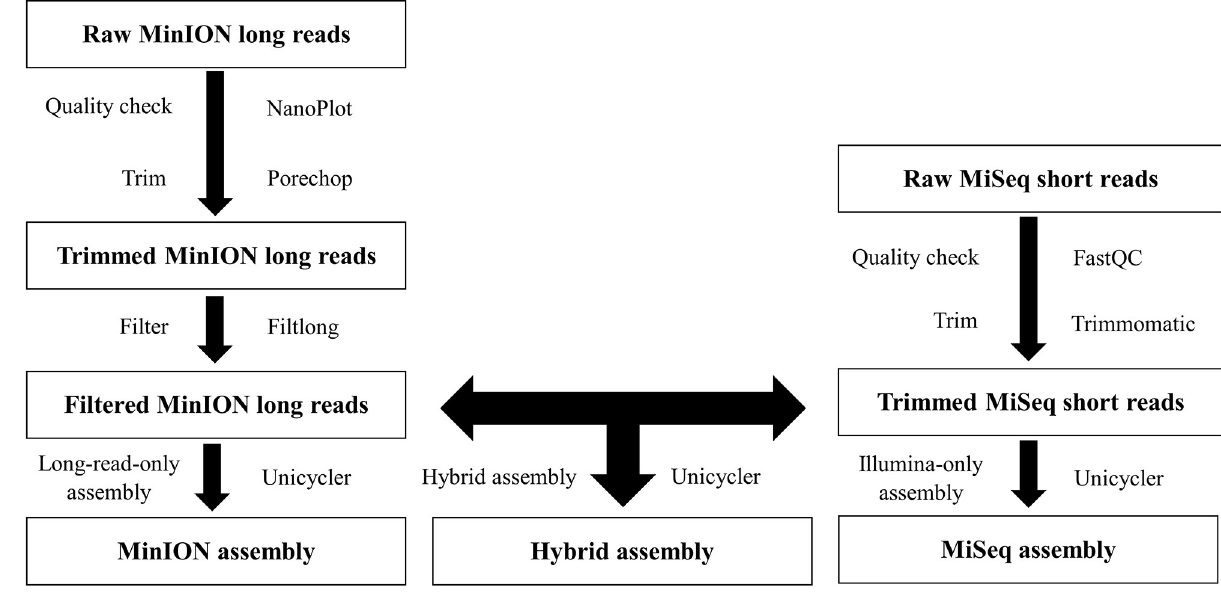
Fig 1. Bioinformatic workflow of the hybrid, MinION, and MiSeq assemblies.